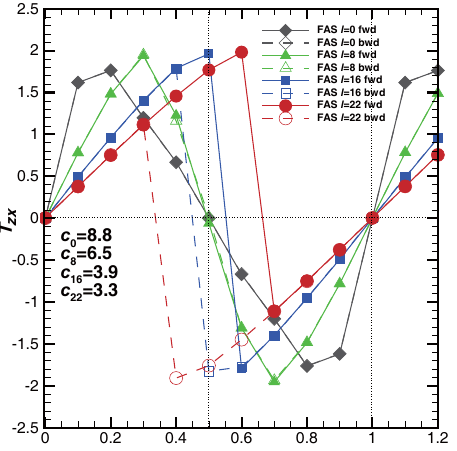
Fig. 5 Shear-stress profile ( T versus register  ) for the models zx with the elastic substrates with a different thickness l at 1 9    , fs T = –1.0 (forward, with a solid line; backward, with T = 0.15, and zz a dashed line). Wholly rigid substrate/0-layer near region (diamonds); 8-layer near region (triangles); 16-layer near region (squares); and fully atomistic/22-layer near region